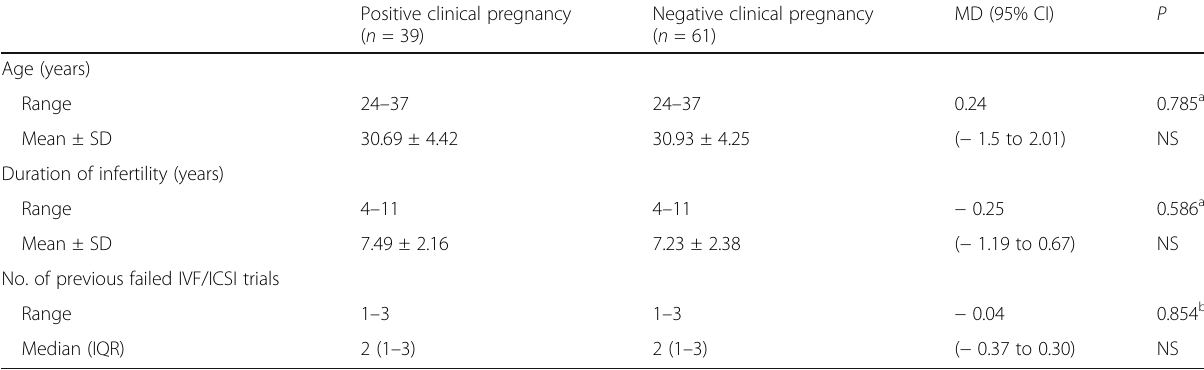
Table 5 Difference between women who had positive clinical pregnancy outcome in repeat IVF/ICSI cycle and women who did not regarding initial